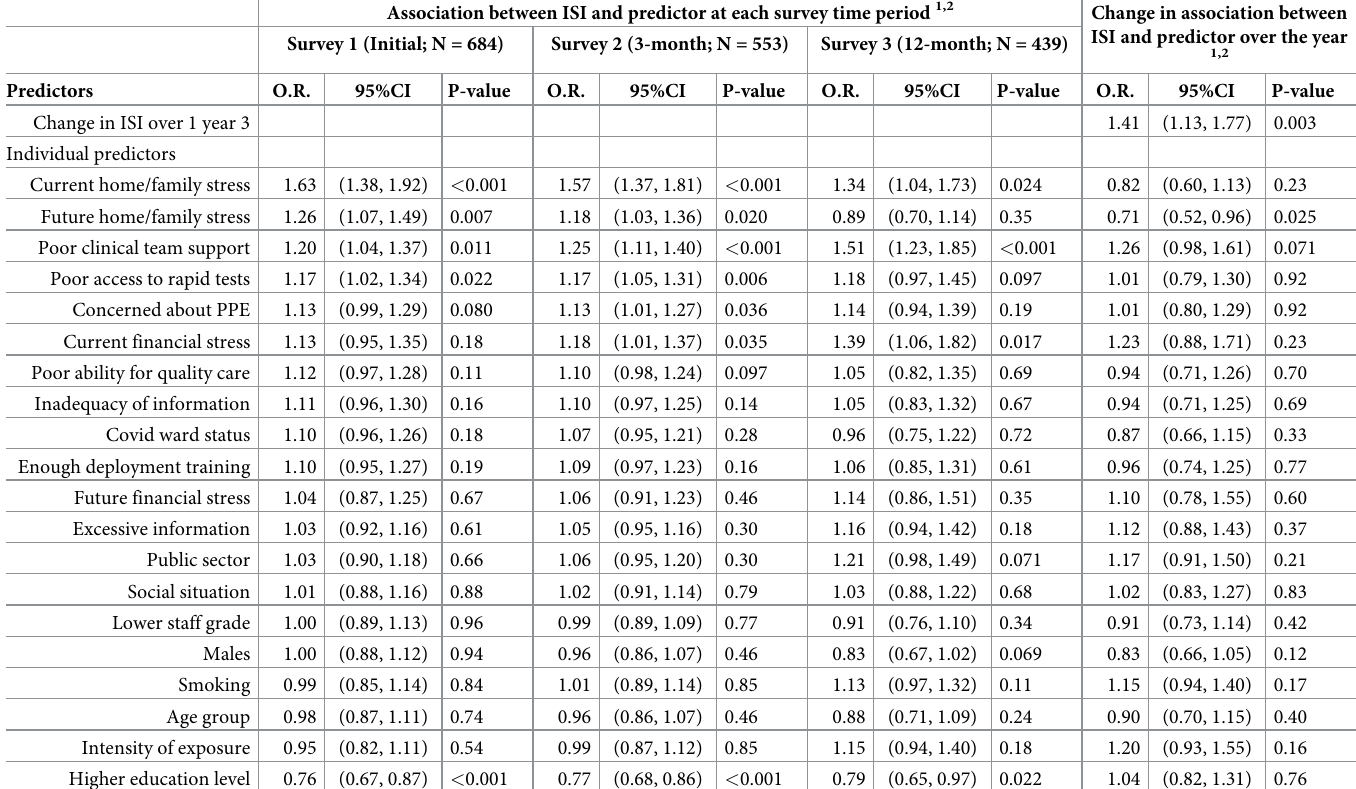
1 Associations between predictors and outcomes, and change in outcomes over 1 year were estimated using repeated-measures ordered logistic regression; the effects were shown as odds ratios (O.R.; 95% confidence intervals; P-values), adjusted for each of the predictors shown in the tables; missing data was substituted by multiple imputation. Odds ratios of 1.00 indicate no association; O.R. more than 1.00 indicate a positive association; O.R. less than 1.00 indicate a negative association. 2 The association between predictors and outcomes in the surveys were estimated for the mean survey completion dates for each survey, set as the zero value of the time interaction predictor: (date of each survey completion by specific respondent minus the mean date of each survey completion). Mean date of survey completion